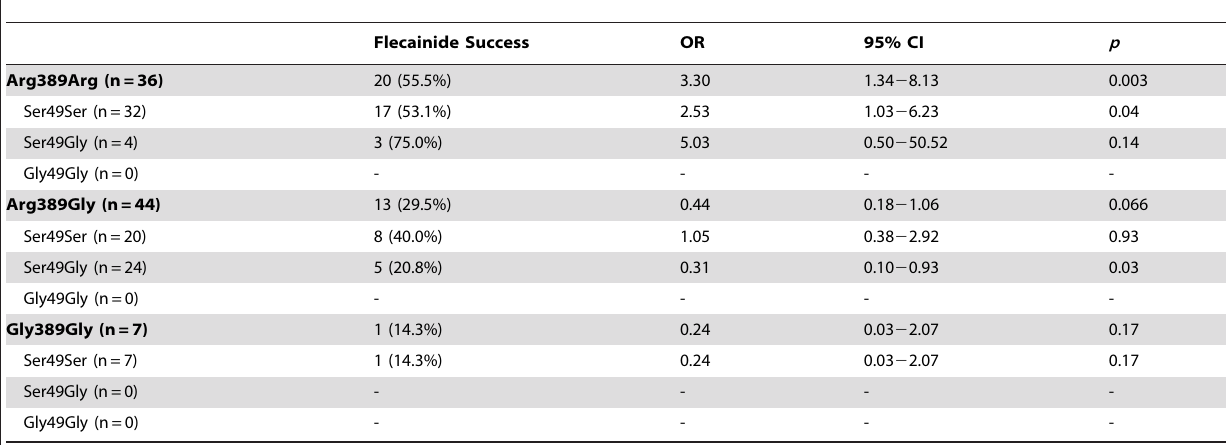
Table 4. Association between different genotypes and the success of flecainide-induced